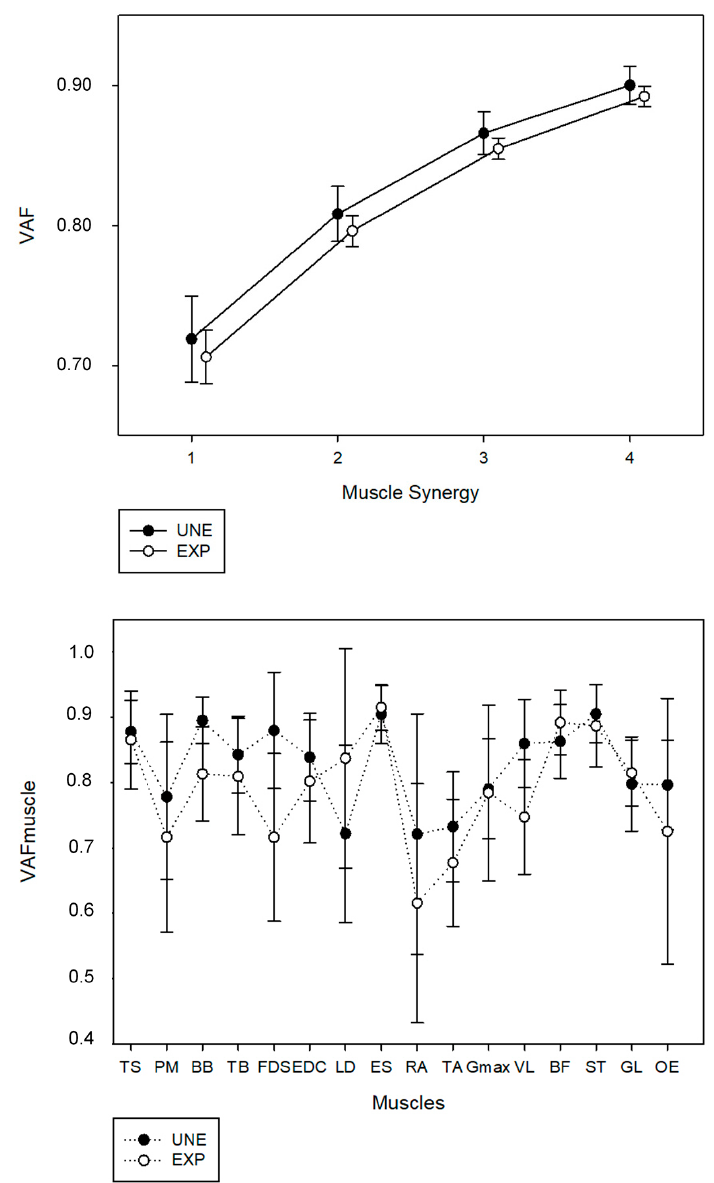
Figure 1. Top panel: Mean values of variance accounted for (VAF) relatively to the original extraction iteration of muscle synergies for unexperienced participants (UNE) and weightlifters (EXP); Down panel: mean values of variance accounted for each muscle (VAF muscle ) regarding a three synergy-model for day one and two.